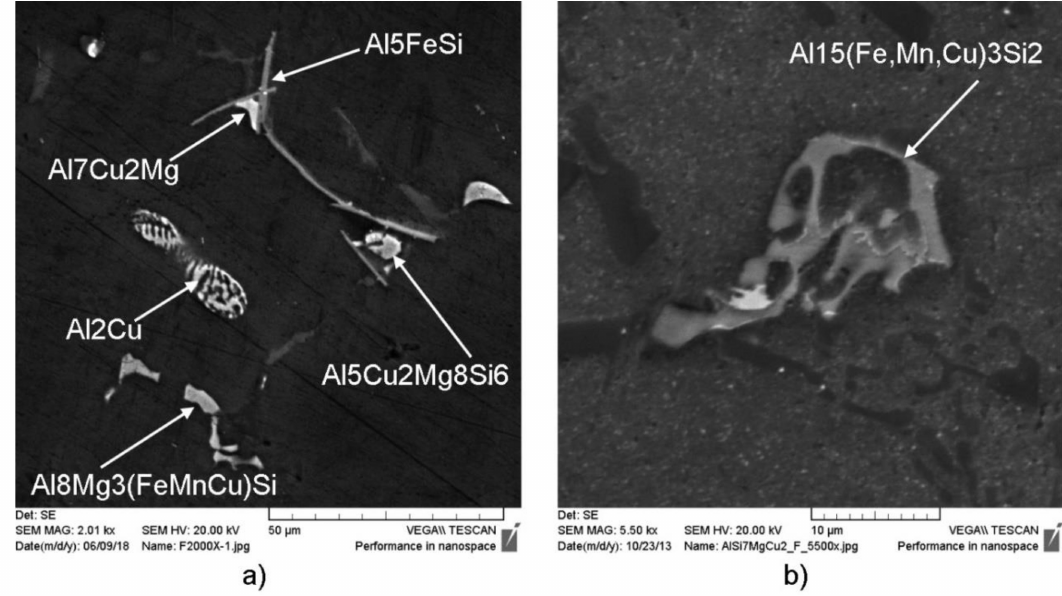
Figure 6. Microstructure of phases in AlSi7MgCu alloy: ( a ) Magnification 2000X, ( b ) Magnification 5500 X.